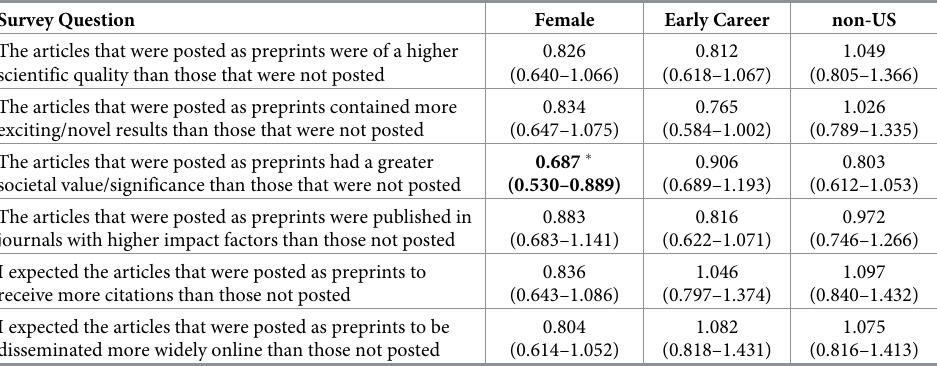
Table 7. Results of ordinal logistic regression for survey questions in Fig 8 (corresponding authorships only; N = 953). Values are presented as exponentiated odds-ratios, with the range in parentheses representing 95% confi- dence intervals. Significant results at the 95% level are indicated in bold and with “ � ”. Survey Question Female